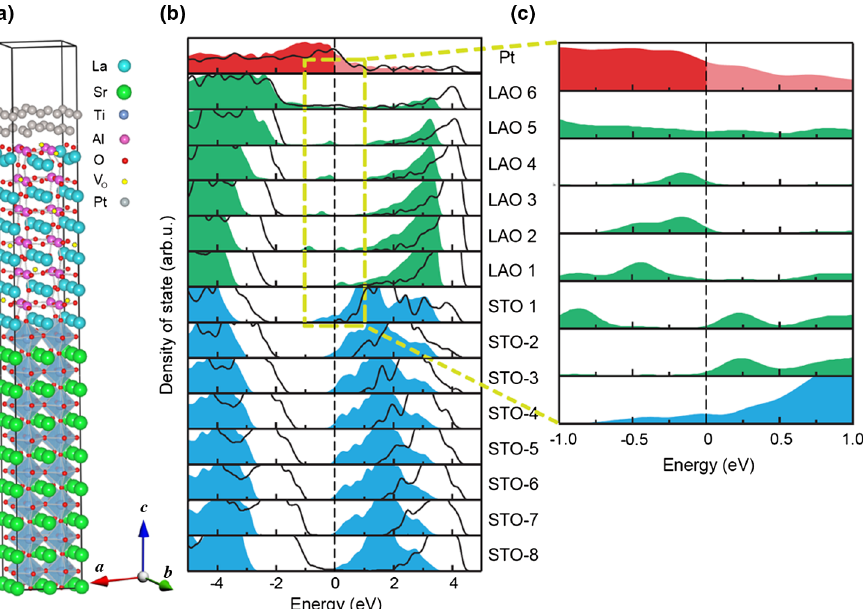
FIG. 6. (a) Simulated structure of the 2 (cid:3) 2 supercell of 1-u.c. Pt/6-u.c. LAO/8-u.c. STO or Pt 1 = ð LAO Þ 6 = ð STO Þ 8 with oxygen vacancies. In this model, we remove one individual oxygen atom from each LAO layer, corresponding to six oxygen vacancies in the ( 2 (cid:3) 2 ) supercell. Accordingly, the concentration of oxygen vacancies is 6 = 72 (cid:4) 8 : 3% . (b) LDOS of the Pt 1 = ð LAO Þ 6 = ð STO Þ 8 system for the ‘‘pristine’’ LAO (without any oxygen vacancy, shown as the black curves) and the ‘‘formed’’ state after incorporation of oxygen vacancies in LAO (filled areas). With the pristine LAO, the Fermi level of Pt falls in the band gap of the LAO, leading to the tunneling transport of the IRS. On the other hand, oxygen vacancies help to produce an extended defect band in the LAO that aligns with the Fermi level of Pt, giving rise to the metallic LRS of the memristor. (c) Close-up view of the LDOS near the Fermi